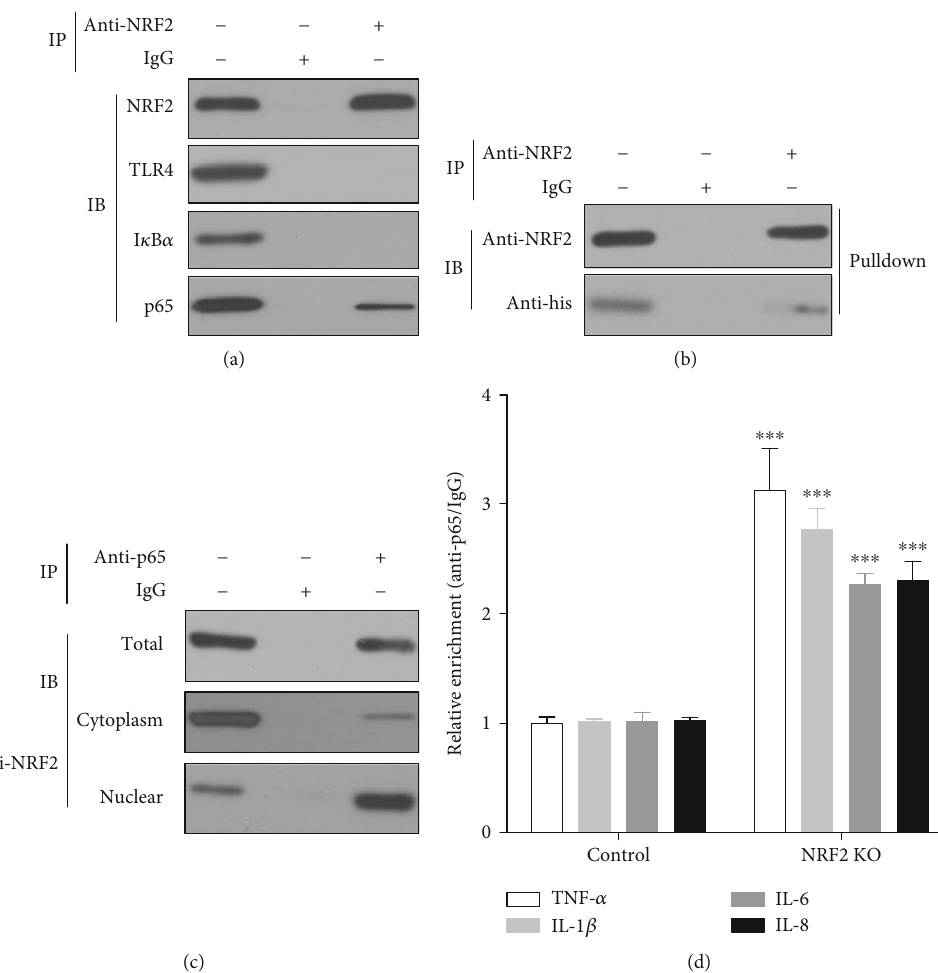
Figure 5: NRF2 binds to p65 in the nucleus, hindering the DNA binding activity of p65. GEECs were harvested and prepared cell lysis after treating with 8 μ g/mL LPS for 12 hours. (a) Immunoprecipitation with NRF2 antibody (Rabbit IgG was used as negative control) and immunoblotting with NRF2, TLR4, I κ B α , and p65 antiboty. (b) Prokaryotic expression of NRF2 protein with his label was incubated with protein A/G beads coprecipitated with NRF2 antibody for 12 hours and immunoblotting with NRF2 and his antibody. (c) Immunoblotting with NRF2 antibody, and (d) ChIP assays were performed with IgG and anti-p65 antibody; ChIP values are shown as fold changes of immunoprecipitated promoter fragments over IgG controls. ∗∗∗ was P < 0 : 001 vs. control group, and P value was calculated by Student ’ s t